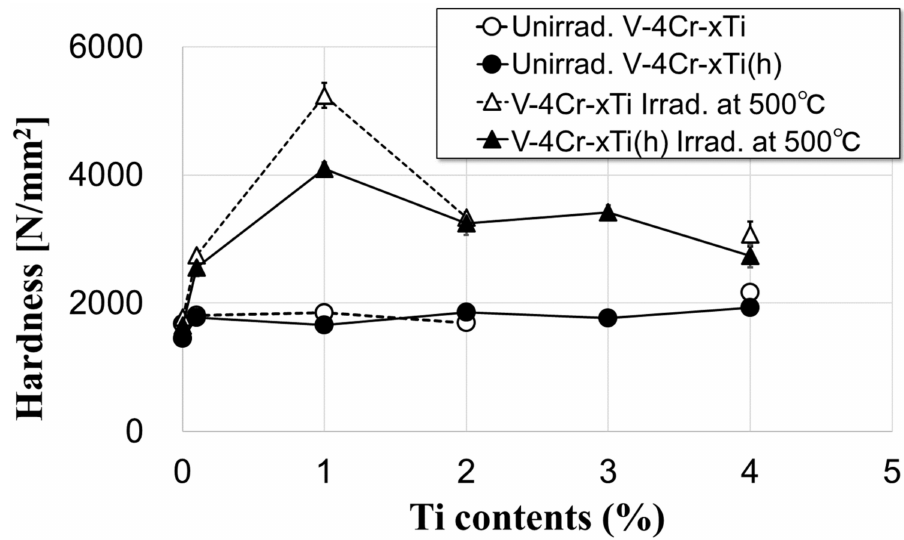
Figure 2. Ti content dependence of nano-indentation hardening for unirradiated V–4Cr–xTi alloys and He-irradiated V–4Cr–xTi alloys at 500 ◦ C.